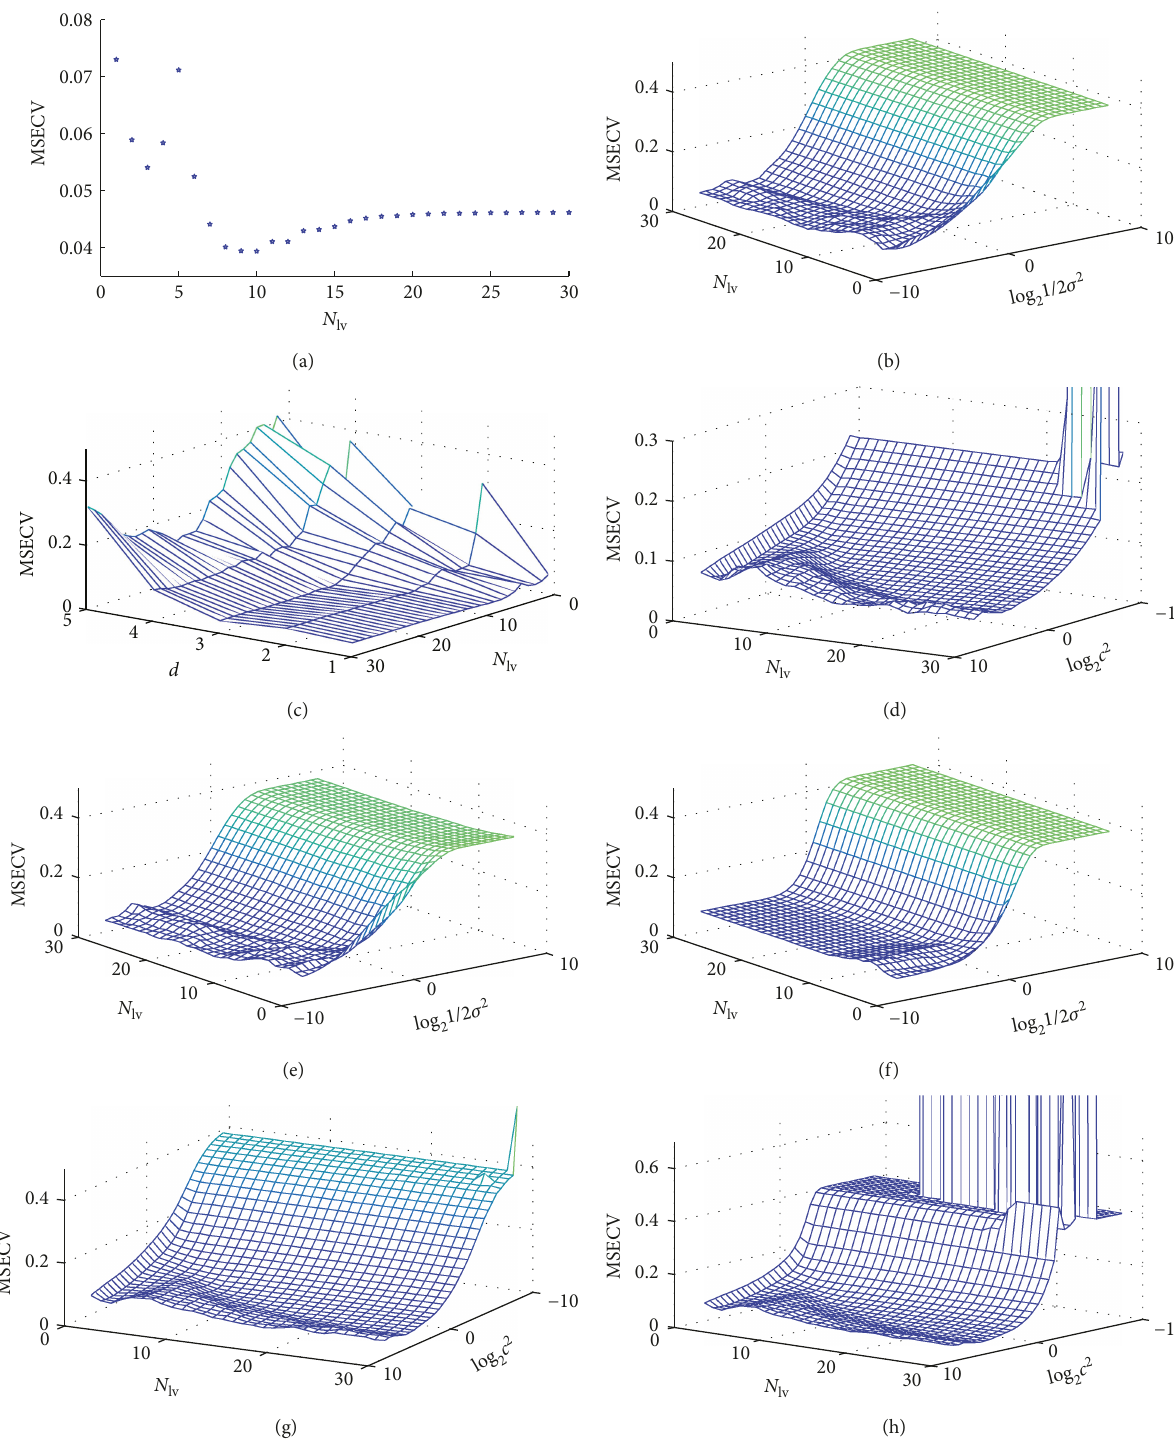
ff erent kernels for KPLS on UA dataset. (a) The in fl uence of N Figure 2: The in fl uence of N lv and kernel parameter on the MSECV of di kernel parameter on the MSECV of PLS. (b – f) The penalty constant and kernel parameter curves of GKPLS, PKPLS, IMKPLS, SLKPLS, EKPLS, RKPLS, and